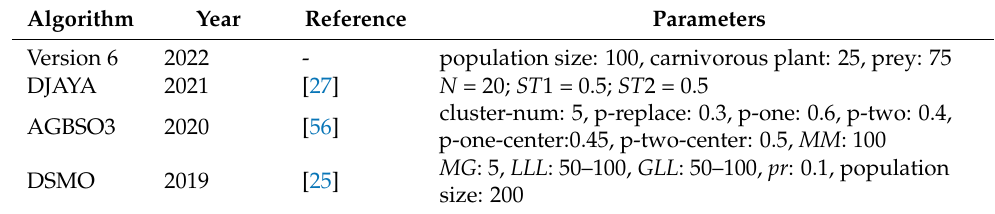
Table 10. Parameter settings of the participating algorithms.